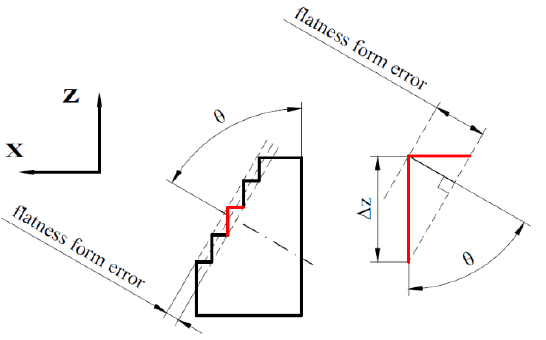
Figure 5. Graphical interpretation of the staircase error caused by a layer-by-layer manufacturing process.